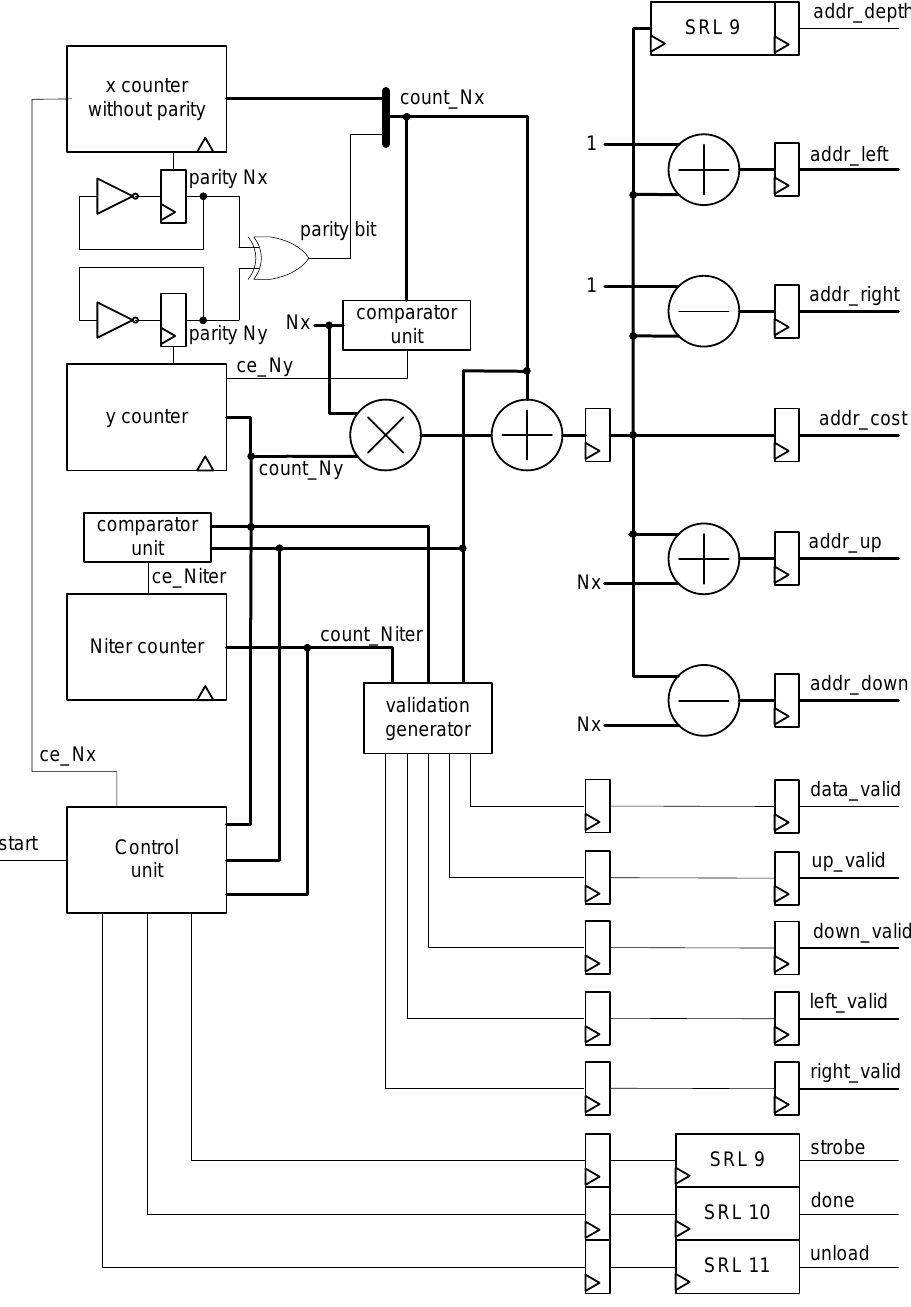
Figure 5. Architectural block diagram of the address